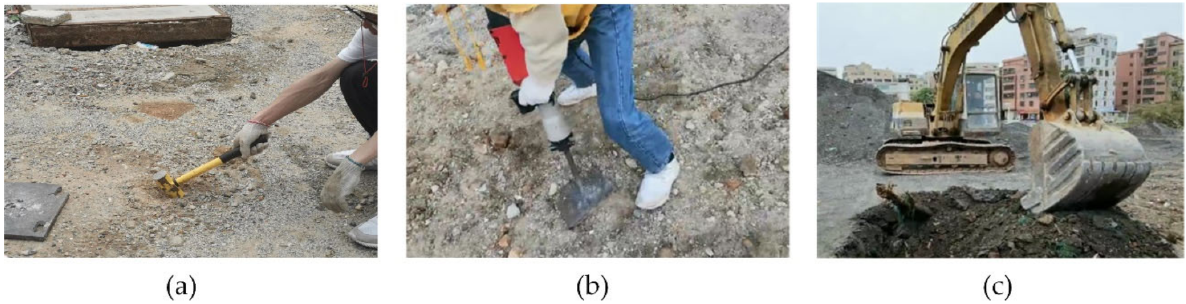
Figure 2. Field tests for collecting vibration signals: ( a ) hammer, ( b ) air pick, and ( c )